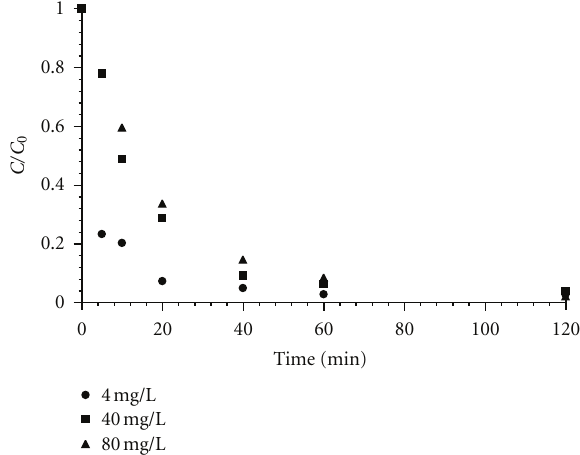
Figure 2: Comparative rates of diclofenac decay, in terms of absorbance, by ozonation (ozone flow = 31 g/h).